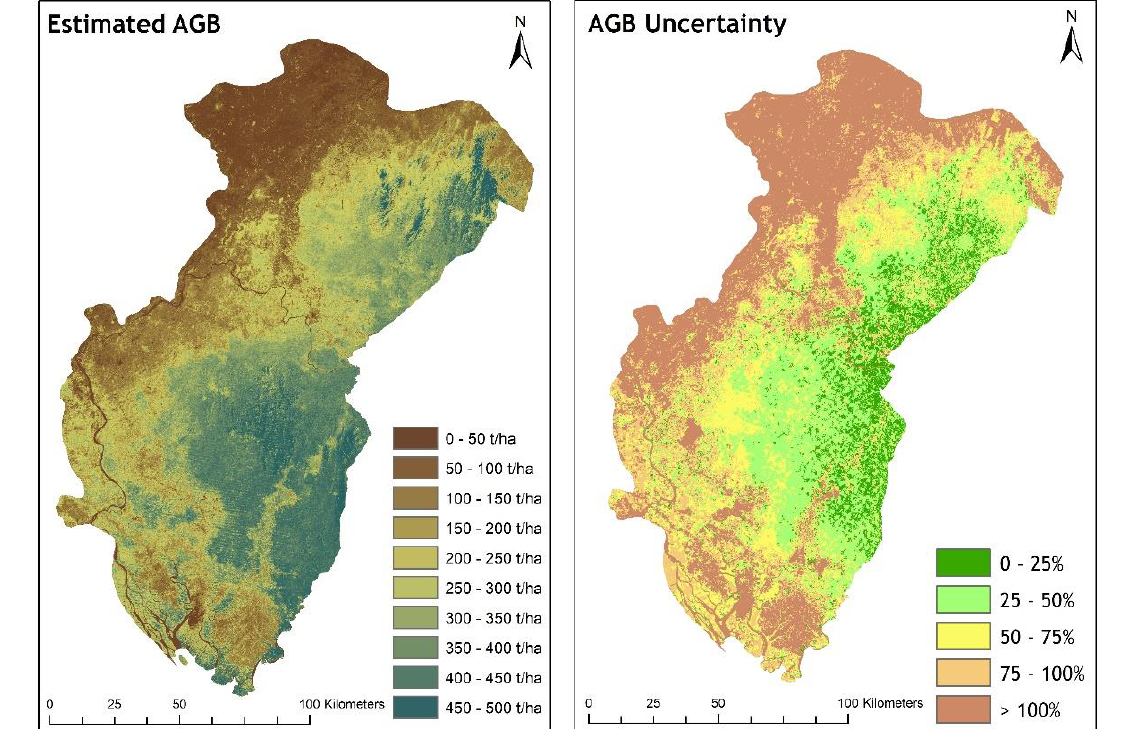
Figure 5. Estimated 20 m resolution map of aboveground biomass for the Cross River State (left- panel), with the resulting uncertainty in AGB incorporating prediction, measurement and allometry errors (right-panel).